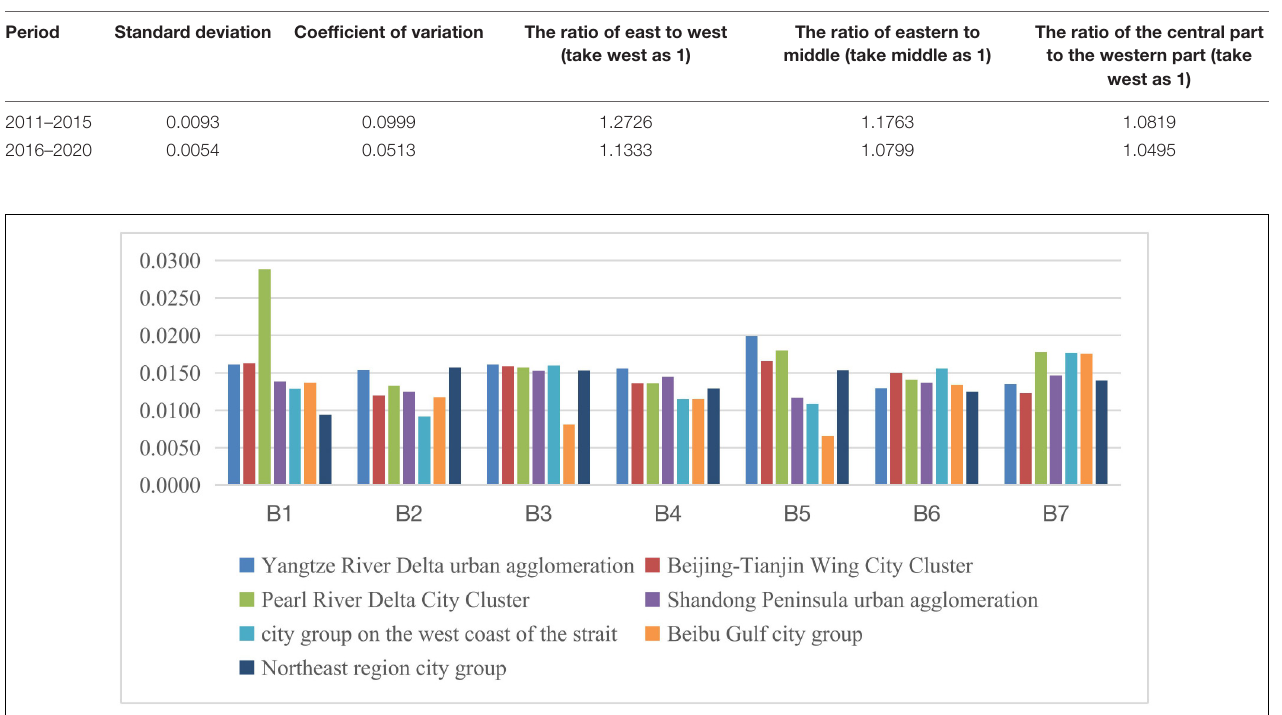
FIGURE 3 | Social development level of each indicator within the eastern region during